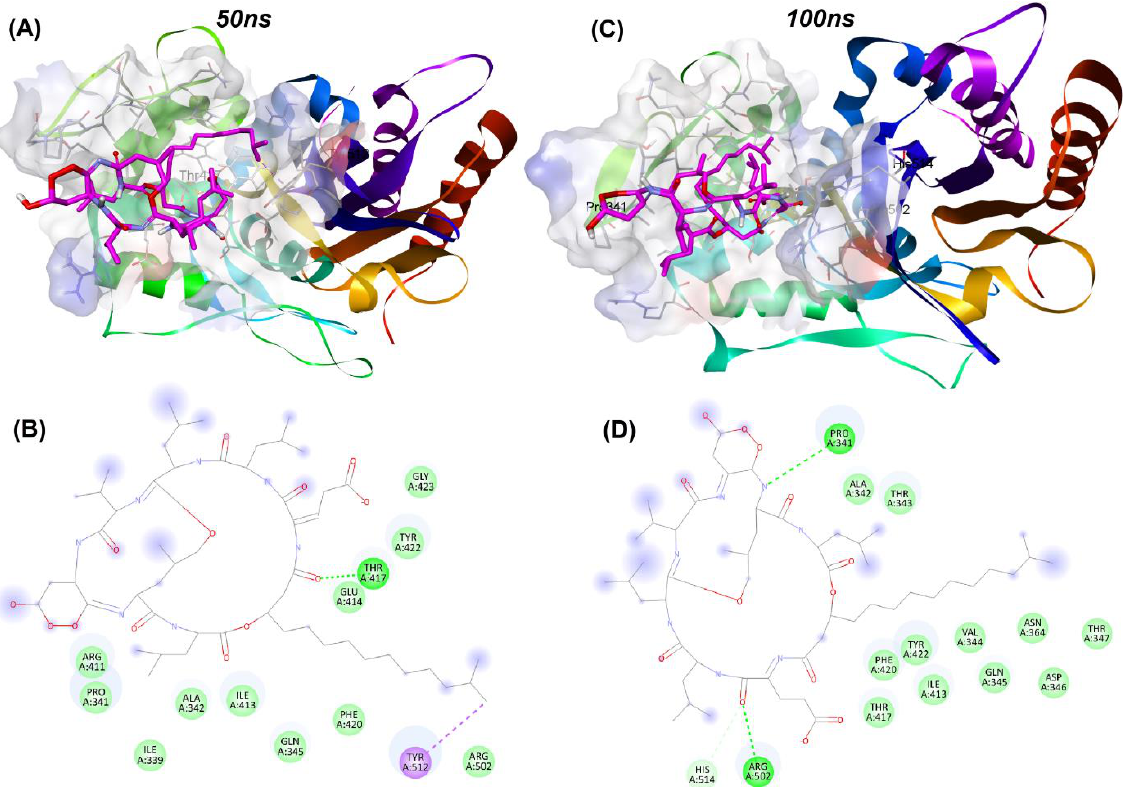
Figure 5. Molecular interactions of surfactin at 50 ns and 100 ns at PBP2 active site ( A ) binding pose of surfactin at 50 ns and ( B ) schematic protein–ligand interaction diagram of the binding of surfactin and PBP2 active site at 50 ns simulation, ( C ) binding pose of surfactin at 100 ns and ( D ) schematic protein–ligand interaction diagram of the binding of surfactin and PBP2 active site at 100 ns simulation.